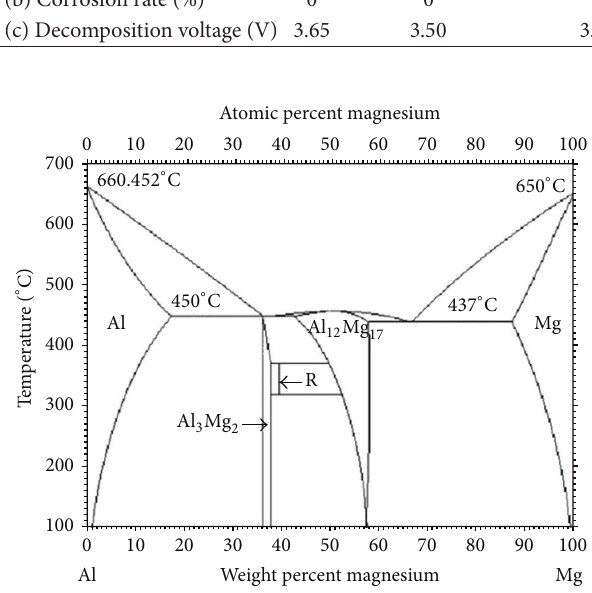
Figure 2: The phase diagram of Al-Mg alloy.